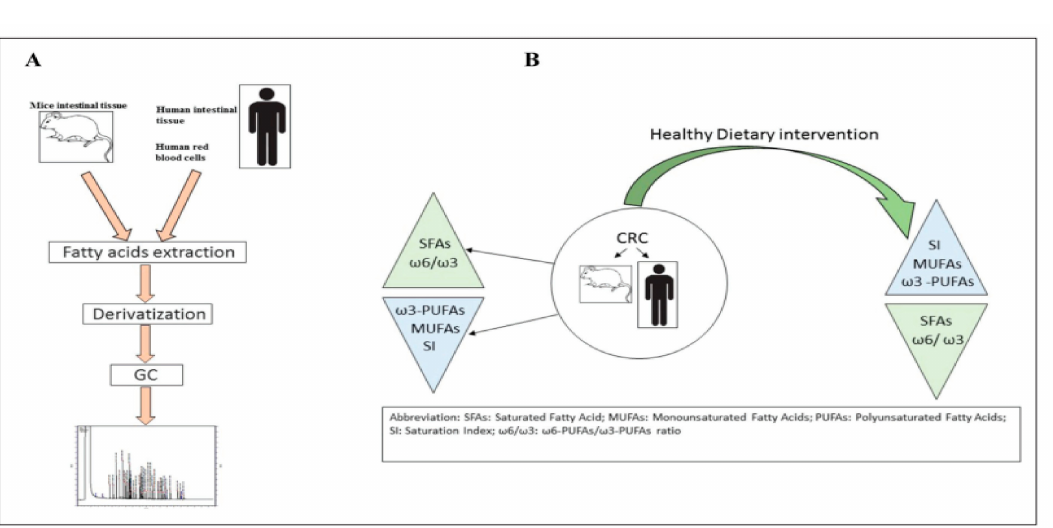
Figure 4. Panel ( A ): Main steps of lipidomic analysis; Panel ( B ): Dietary intervention e ff ects (reproduced with permission from